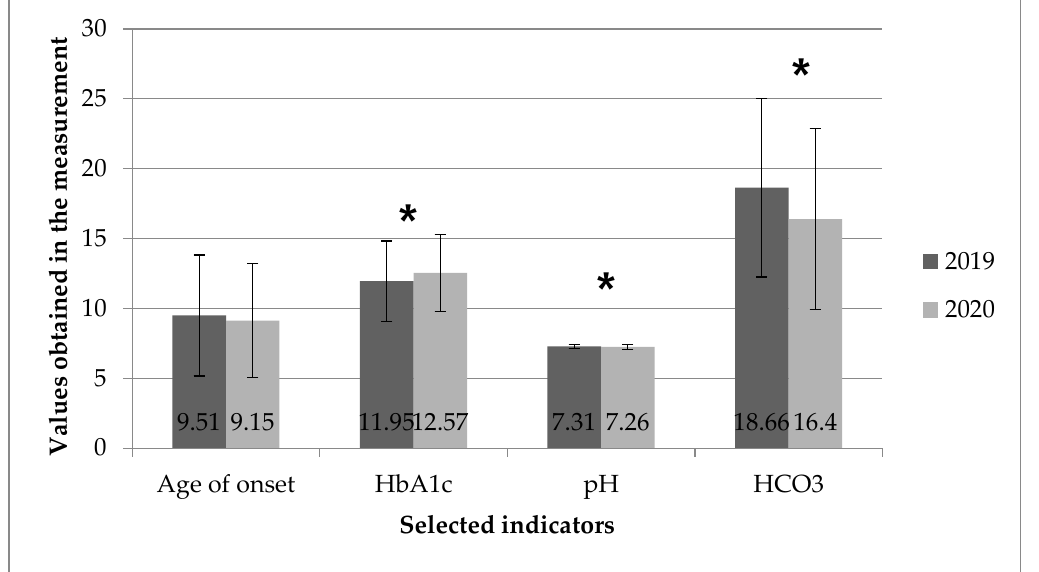
Figure 2. Mean values and standard deviation of the parameters of children at the time of clinical diagnosis of T1D: age, HbA1c, pH, HCO3 in 2019 and 2020. * — p < 0.05.